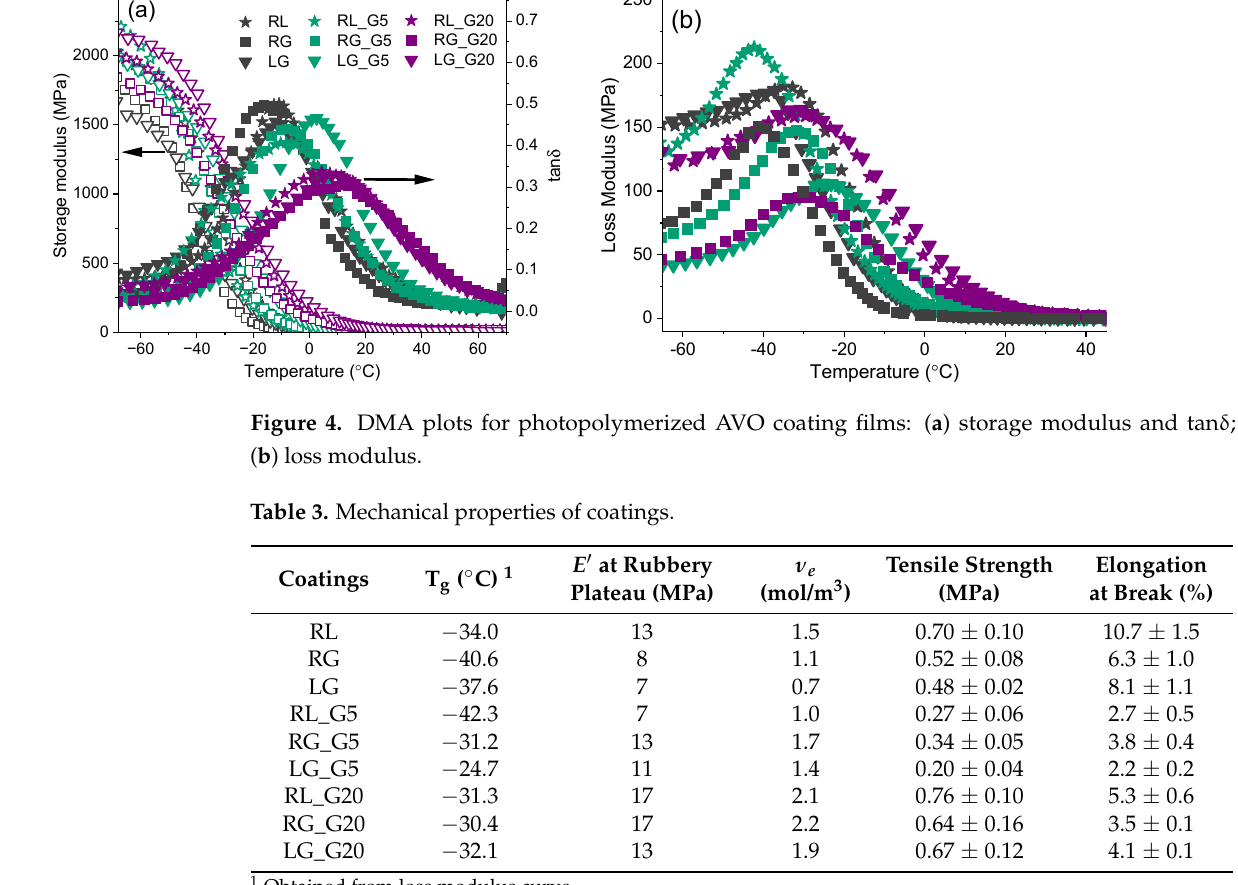
Figure 5. Tensile strength of vegetable oil-based coatings; ( a ) stress–strain curves; ( b ) Young’s mod- ulus.